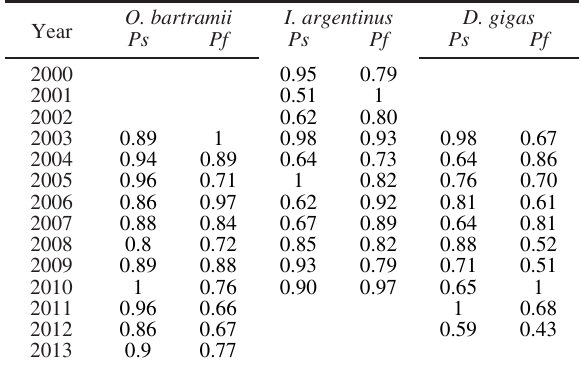
Table 3. – Time series indices of Ps and Pf for O. bartramii , I. ar- (Table 4). The distributions of all three parameters gentinus and D. gigas . were positively skewed (Fig. 3). The estimated MSY ranged from 10×10 4 to 45×10 4 , with a mean value of 14×10 4 t (Fig. 3).